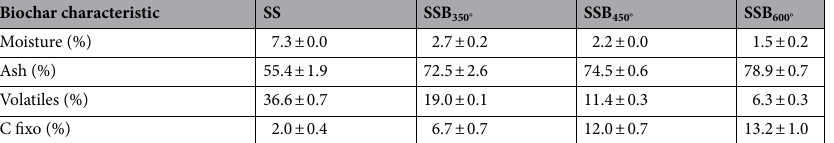
Table 1. Proximate analysis of sewage sludge (SS) and sewage sludge biochars (SSB) produced at 350 (SSB 350 ), 450 (SSB 450 ) and 600 (SSB 600